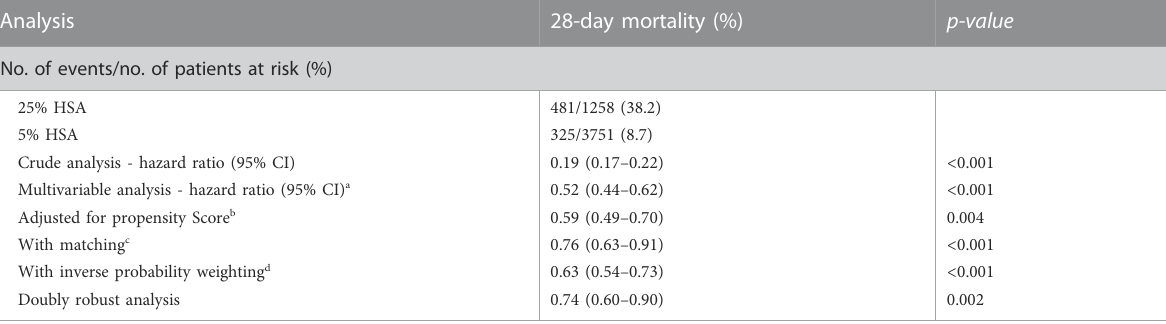
TABLE 3 Associations between 5%HSA and the 28-day mortality.